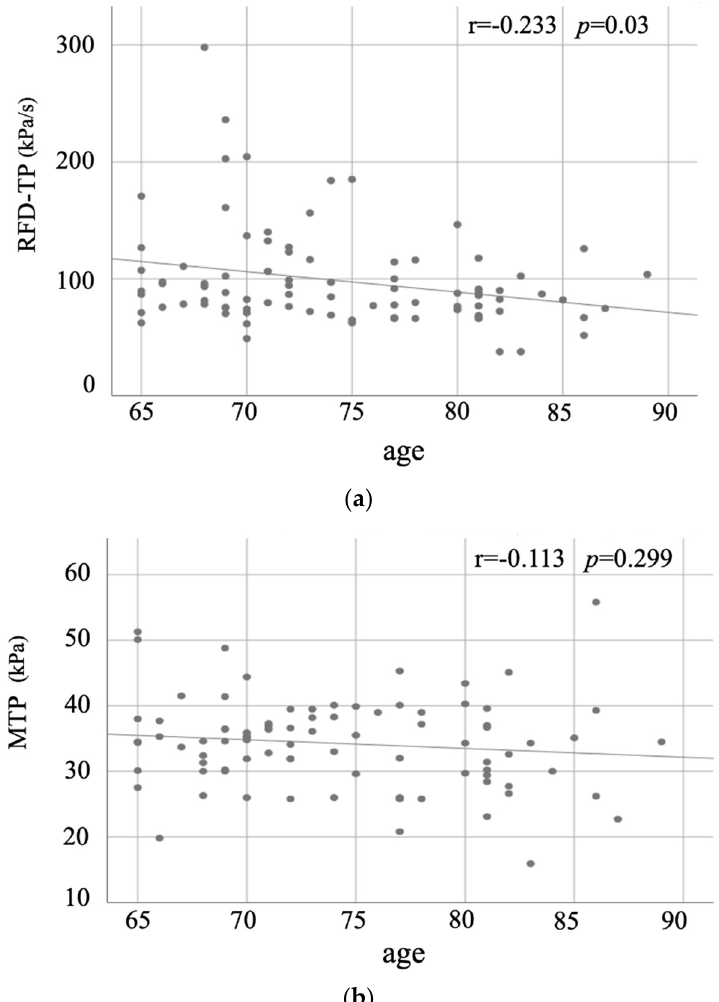
Figure 2. Scatter plots depicting ( a ) the relationship between the rate of force development of tongue pressure (RFD-TP) and age and ( b ) the relationship between the maxi-mum tongue pressure (MTP) and age. The RFD-TP showed a significant negative correlation with age (r = − 0.233, p = 0.03), but MTP had no significant correlation (r = − 0.113, p = 0.299). Table 2. Correlations between RFD or MTP and evaluated factors.